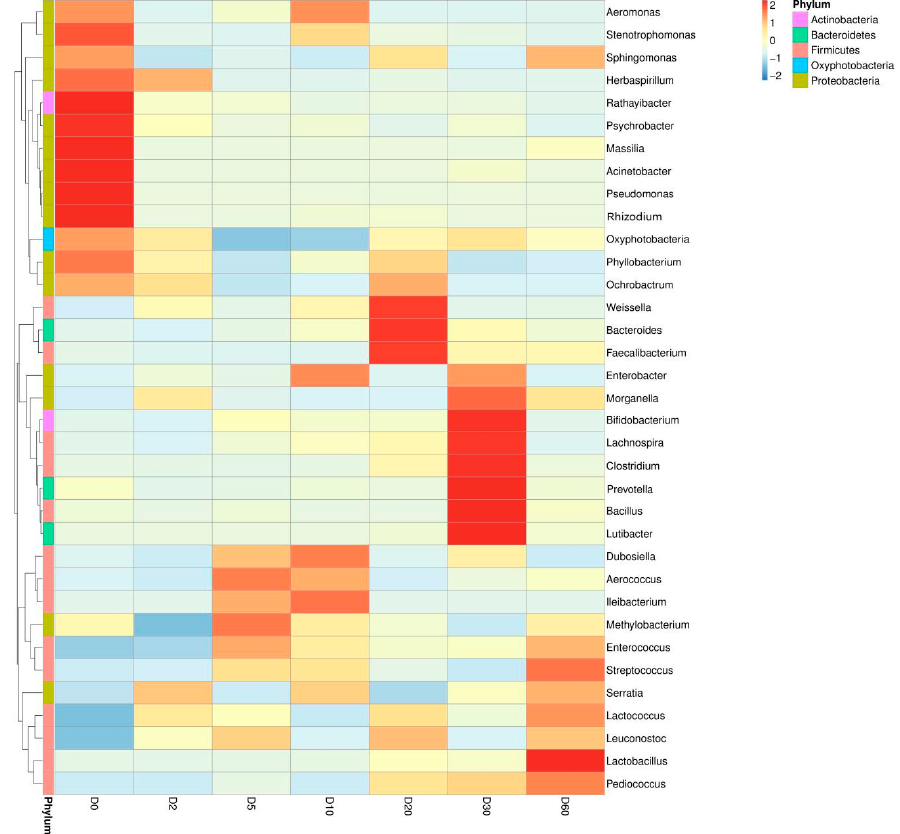
Figure 3. Cluster heat map of bacterial community abundance in silage. The abscissa stands for the silage time (on day 0, 2, 5, 10, 20, 30, and 60) and the ordinate stands for the relative abundance of each bacterial community at the genus level or phylum level.